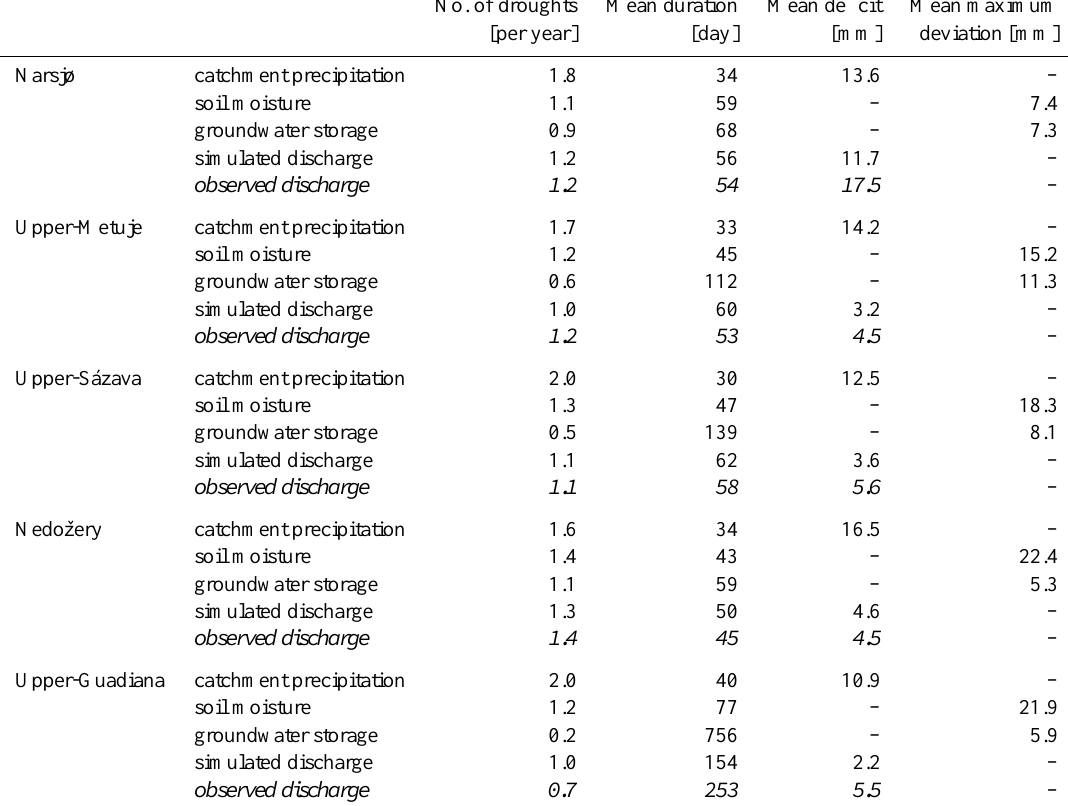
Table 3. General drought characteristics using an 80% monthly threshold (moving average 30 days), the inter-event time method for pooling, and a minimum drought duration of 15 days for the hydro-meteorological variables simulated with HBV and observed discharge for all selected